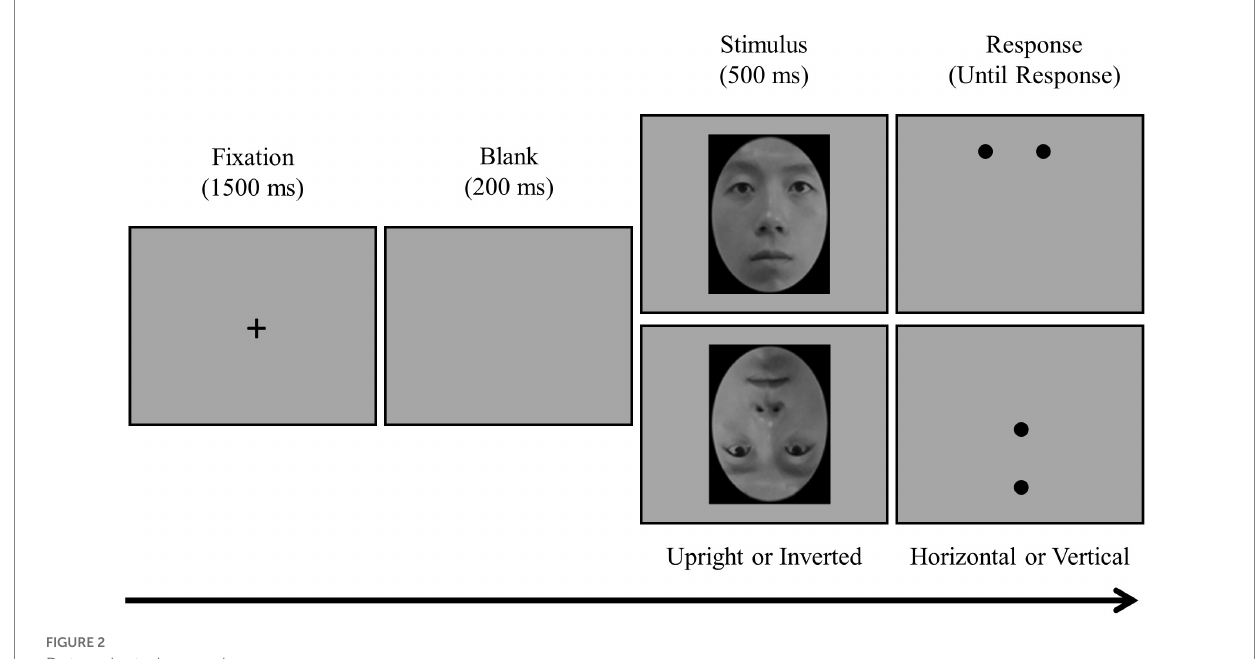
FIGURE 2 Dot-probe task